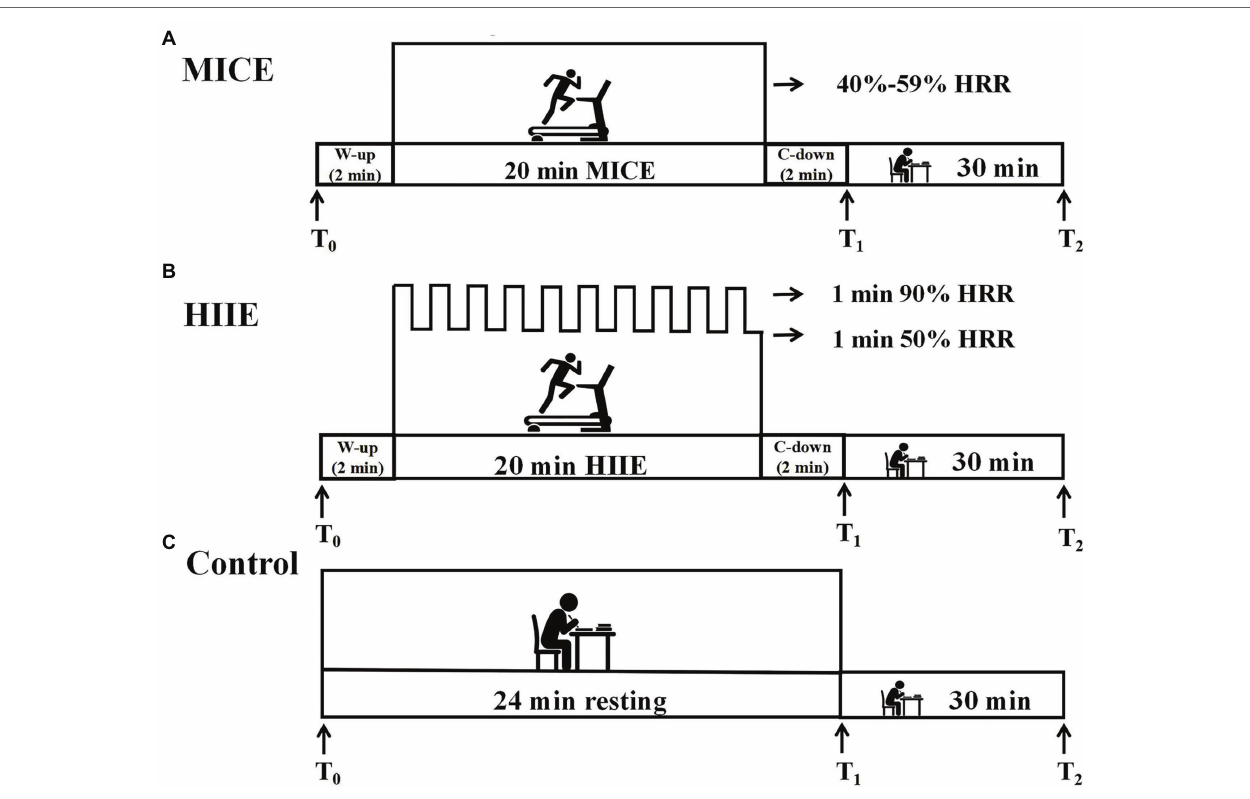
FIGURE 2 | Schematic of the study design. Working memory was assessed pre-intervention (T 0 ) and at two time points after intervention, including immediately (T 1 ) and 30 min (T 2 ). MICE: moderate-intensity continuous exercise. HIIE: high-intensity interval exercise. W-up: warm-up. C-down: cool-down. Sections (A–C) of the figure represent the intervention protocols for the HIIE, MICE and control group